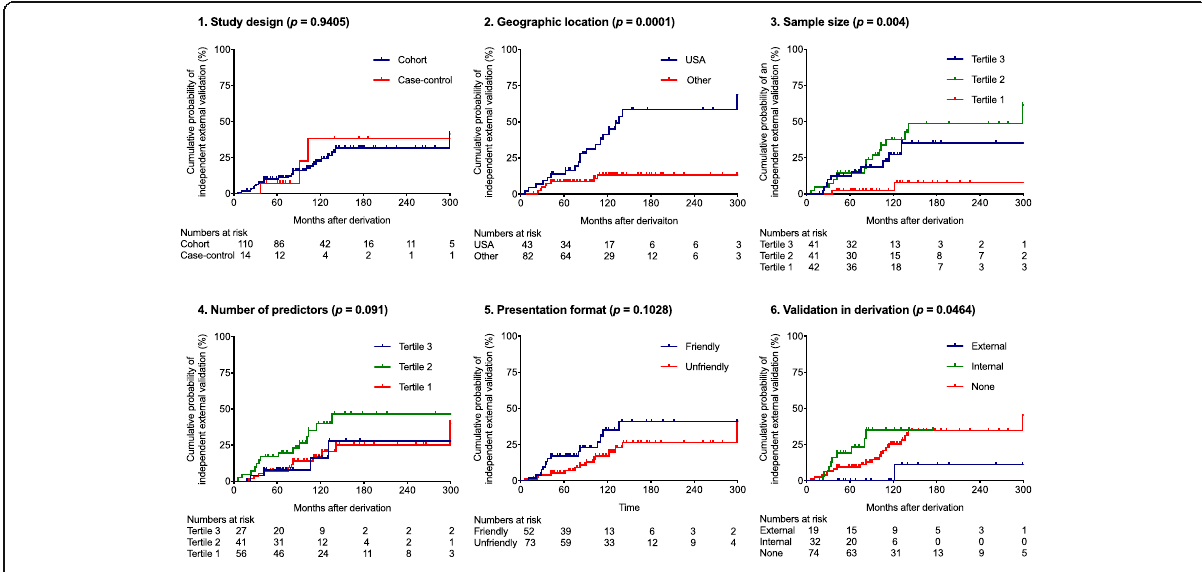
Fig. 3 Kaplan-Meier plot. Probability of an independent external validation for derivation-related predictor variables